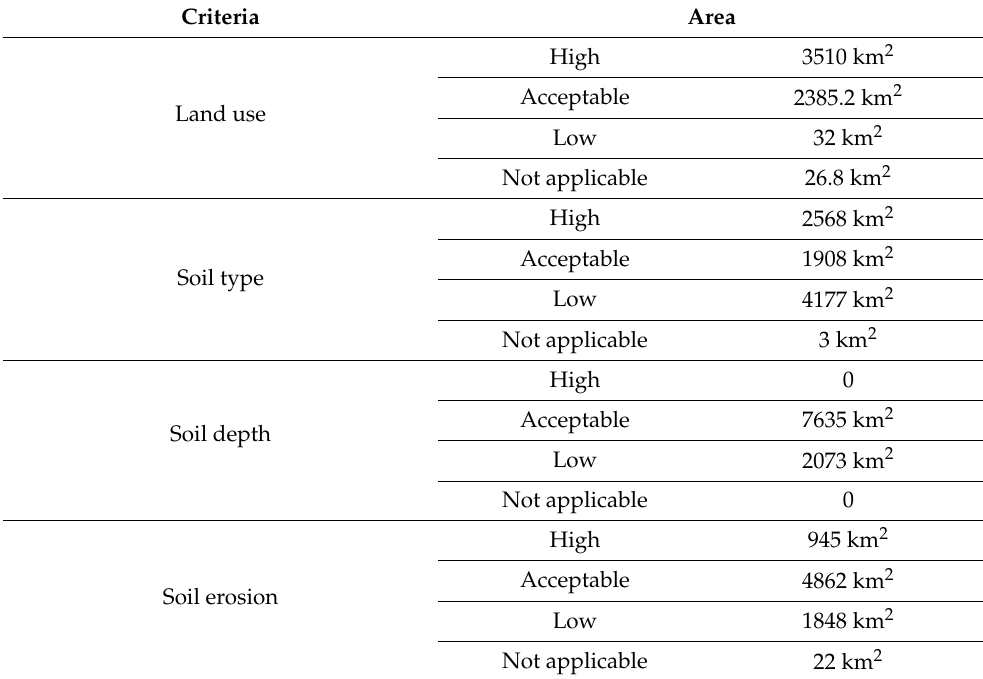
Table 2. Fuzzy set memberships, membership functions, and areas used for the BWWT system in